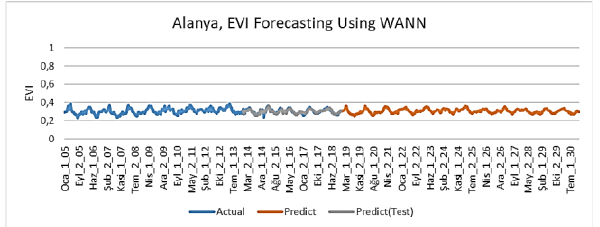
Figure 6. Forecast using WANN between